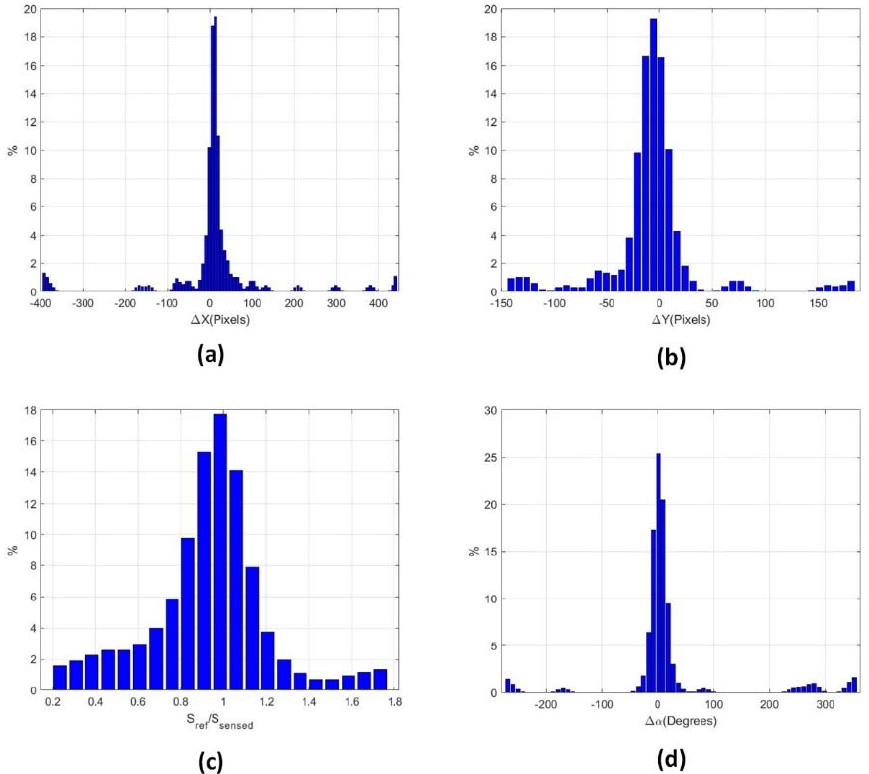
Figure 4. ( a − d ) Histograms of horizontal shifts, vertical shifts, scale ratio, and main direction differ- ence.